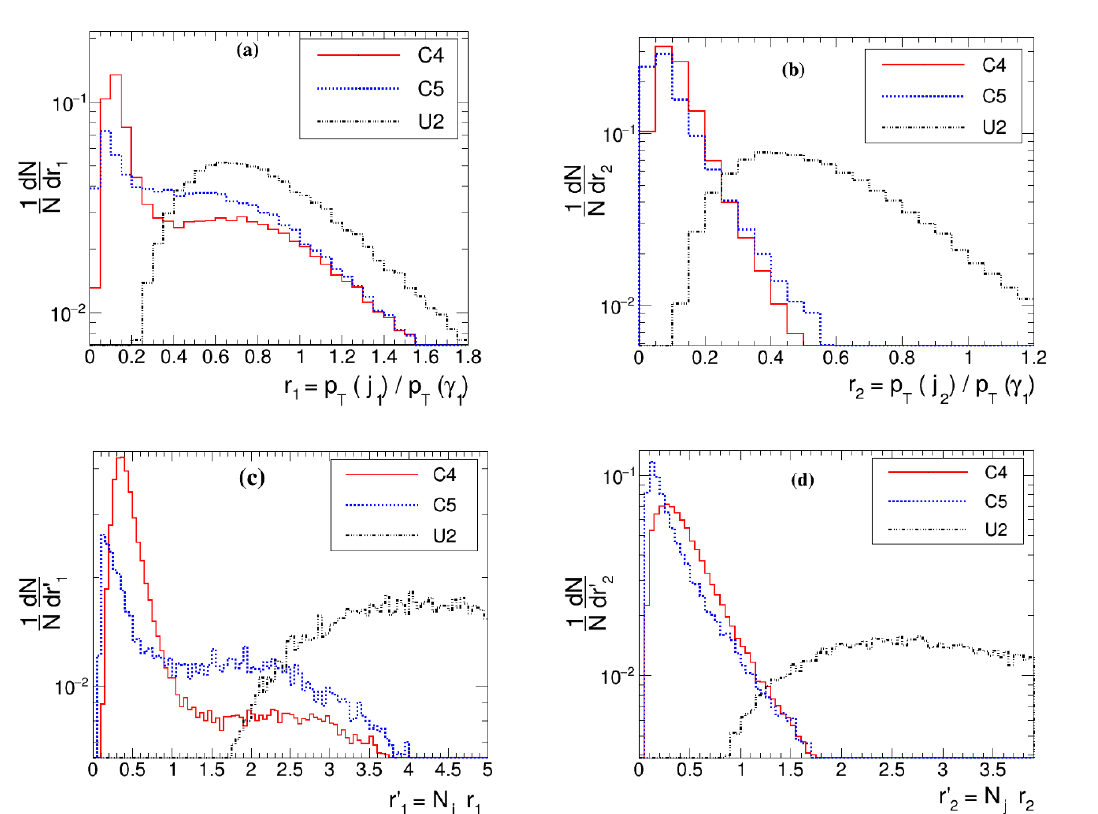
Figure 7 . Normalized distributions of di(cid:11)erent kinematic variables r 1 , r 2 , r 0 compressed and uncompressed scenarios for some of the benchmark points representing various compressed ( C4 ), more compressed ( C5 ) and uncompressed ( U2 ) spectra after implementing the selection and analysis cuts A0 { A6